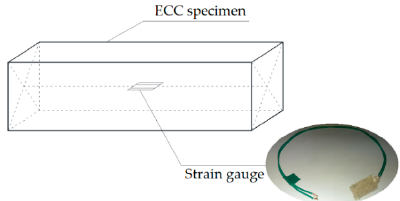
Figure 6. The location of strain gauge in the ECC specimen.